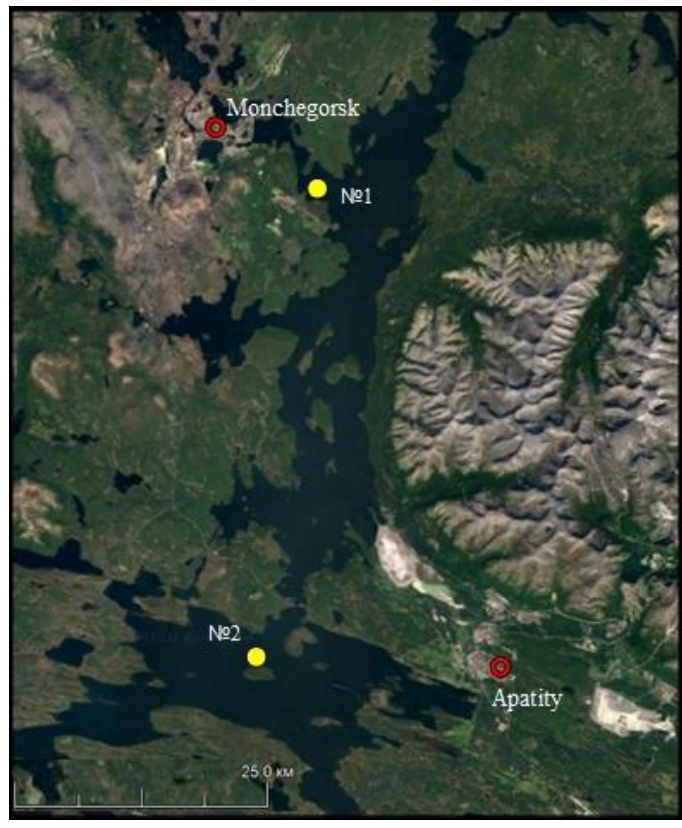
Figure 1. Scheme of sampling points.